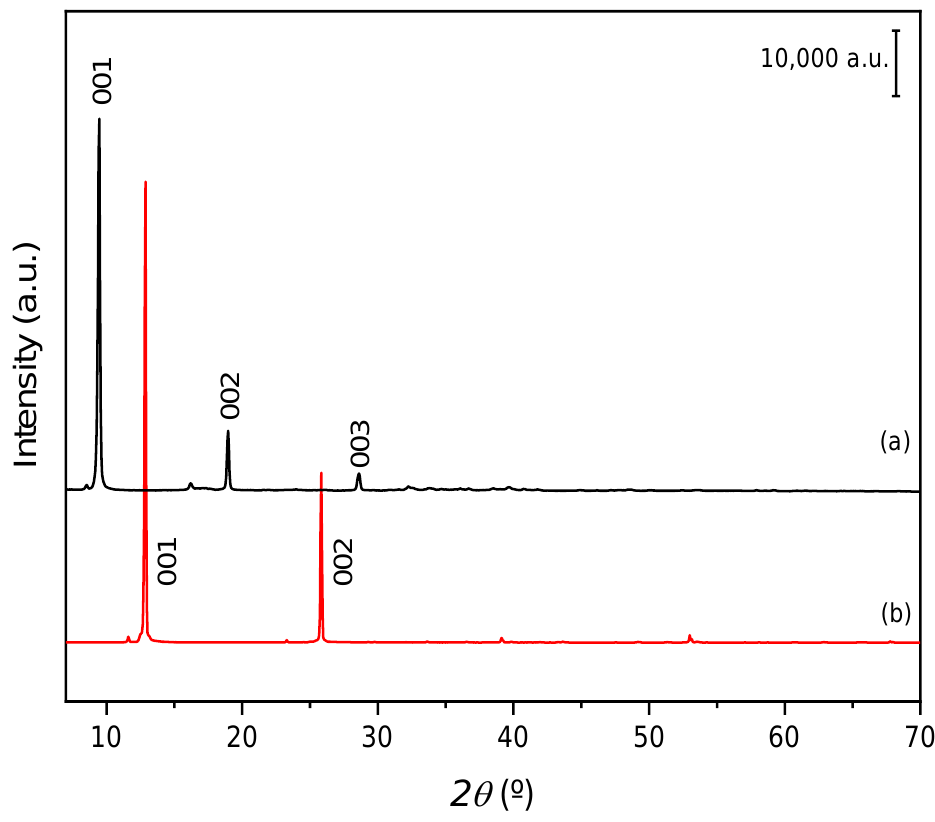
Figure 1. X-ray diffraction patterns of (a) copper hydroxy acetate and (b) copper hydroxy nitrate. The copper hydroxide acetate shows a layered pattern of X-ray diffraction (Figure 1a), with basal plane diffraction peaks (001, 002 and 003) that correspond to an interplanar spac- ing of 9.91 Å [11,45]. For the copper (II) hydroxy nitrate (Figure 1b), the X-ray diffraction pattern agrees with a monoclinic phase, and the basal distance corresponds to 6.85 Å to peak 001, and its multiple 002